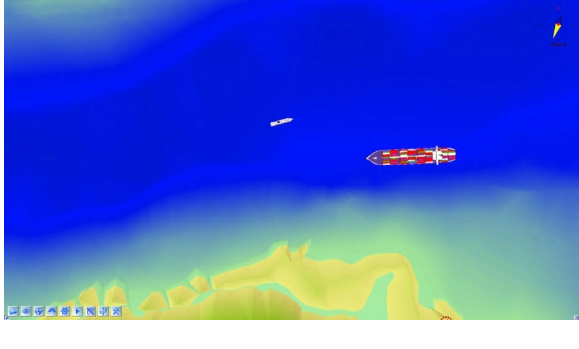
Figure 10. A vertical view.